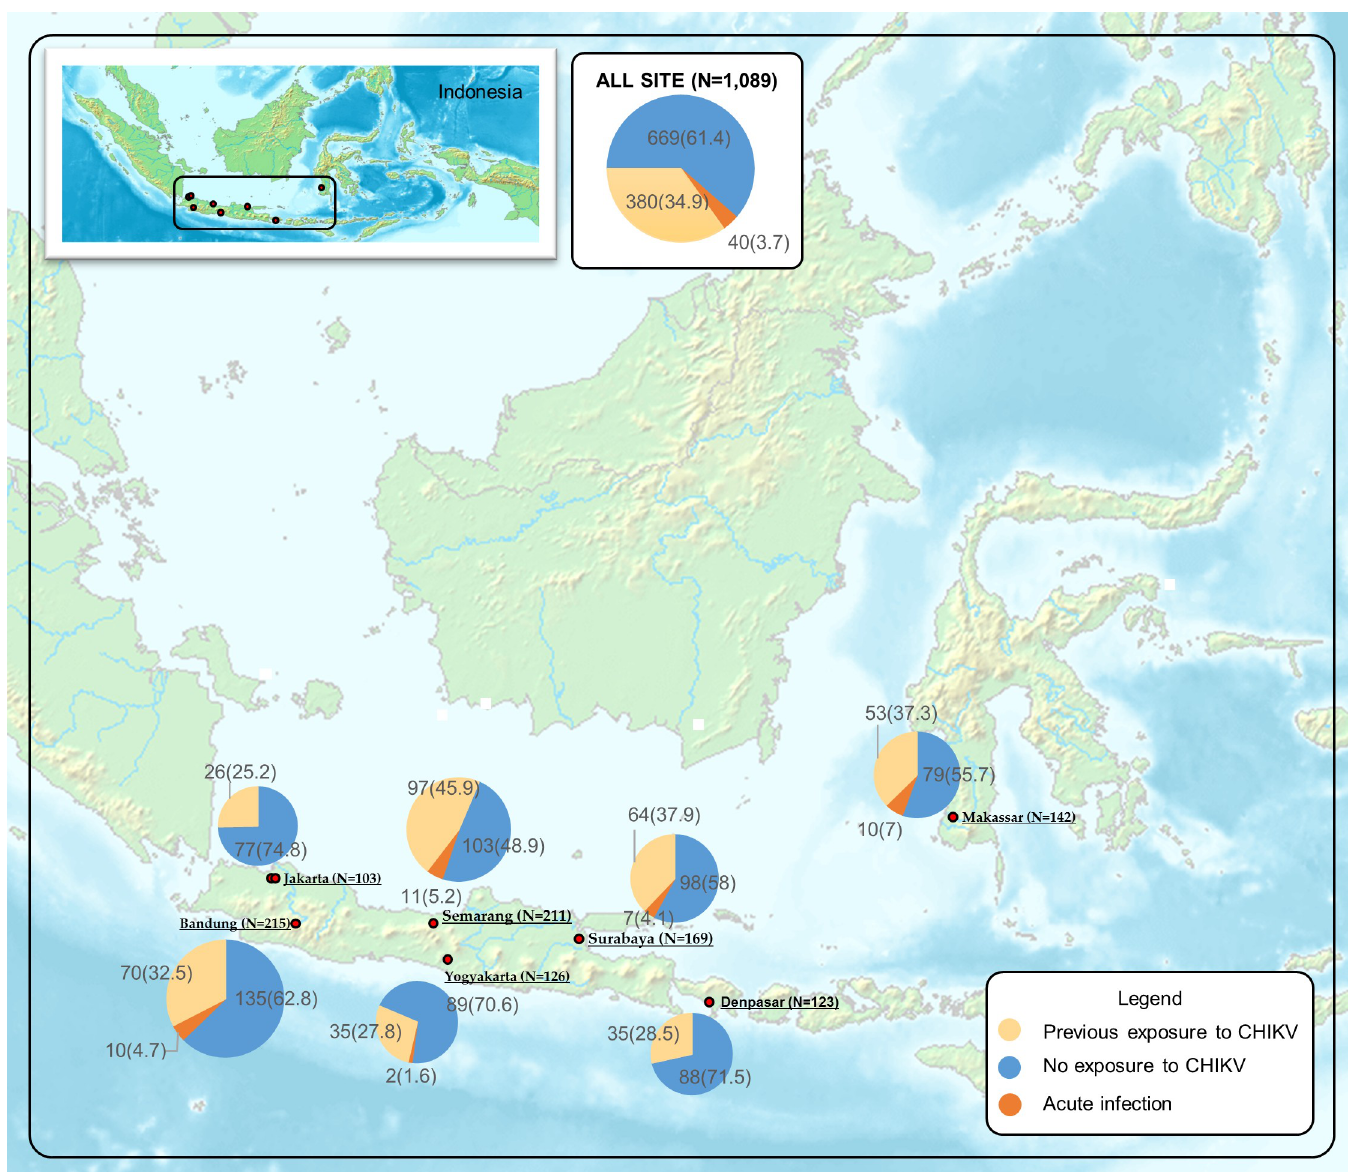
Fig 2. The distribution of Chikungunya virus exposure in Indonesia. Acute CHIKV infection (ACI) : CHIKV RNA was detected by rRT-PCR and/or sero-conversion or four-fold increase in OD ratio of IgM and IgG between paired samples was observed; Previous infection : no evidence of ACI, IgG was positive in acute specimens; No exposure of CHIKV : IgG was negative in convalescent specimens. Map source Wikimedia Commons Atlas of the World [Atlas of Indonesia] . Available from: https:// commons.wikimedia.org/wiki/Atlas_of_Indonesia#/media/File:Map_of_Indonesia_Demis.png [Accessed 21 October 2019]. The remaining 20 subjects were diagnosed with unspecified fever (6), respiratory infection (5), non-specific viral infections (4), fever with rash (2), enteritis (2), and endocarditis (1) (Table 2). In 3 of the 6 unspecified fever cases, dengue or S. typhi rapid test was negative. No rapid diagnostic test was done in two elderly patients with suspected lower respiratory infec- tions who had underlying diseases (coronary artery disease and hypertension, and hyperten- sion and osteoarthritis). Rapid dengue or S. typhi tests were done in all the 3 cases with upper respiratory tract infection (URTI), and in 3 of 4 with suspected viral infection. All results were